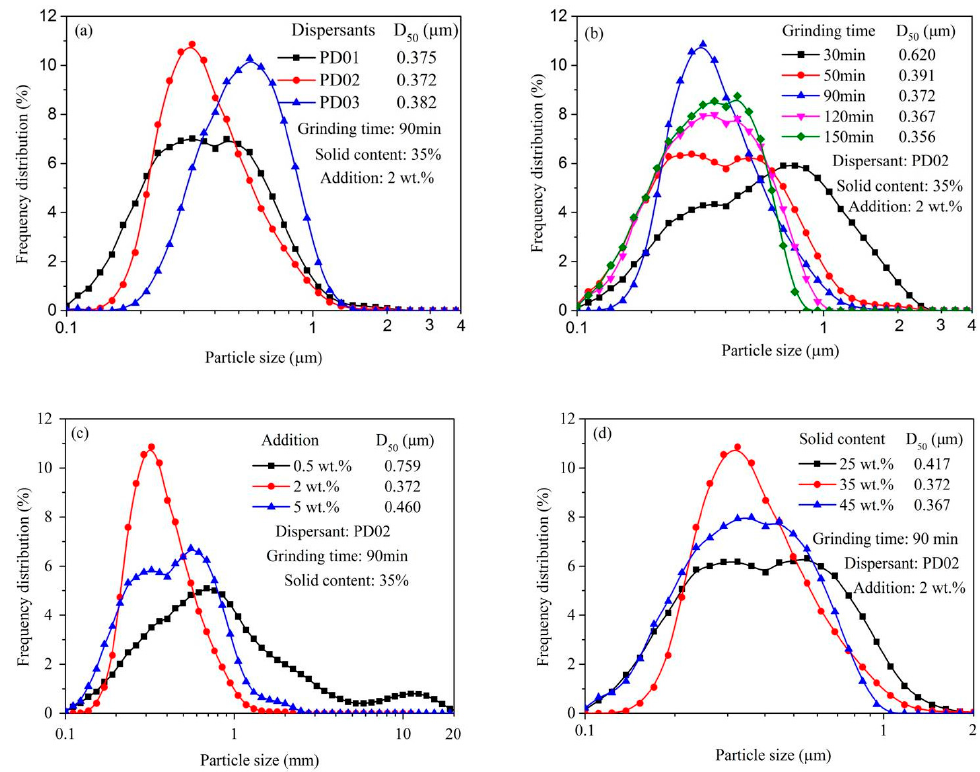
Figure 6. The particle size distribution and median size (D 50 ) of the S-ZnF particles with dispersant PD0x (PD01, PD02, and PD03) at 2 wt.% addition ( a ), with different grinding time ( b ), amounts of dispersant PD02 ( c ), and at different solid contents ( d ).